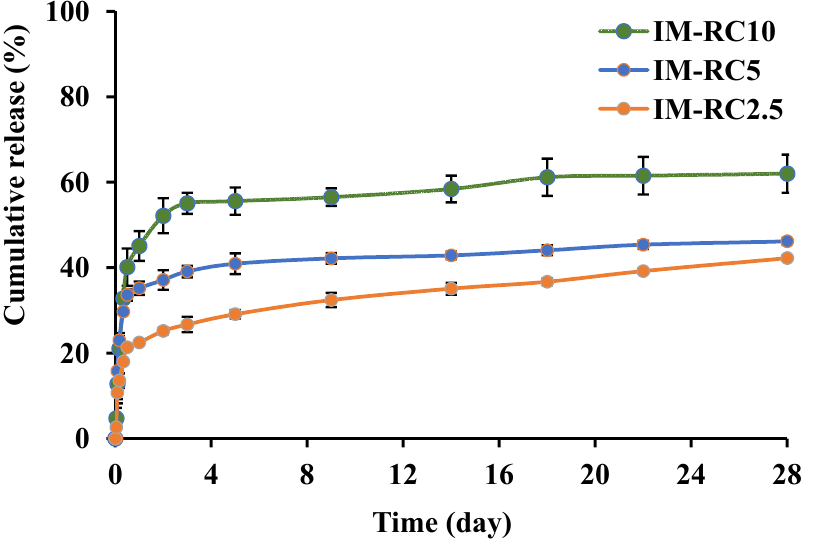
Figure 6. Effect of CO concentrations (2.5%, 5% and 10%) on the IM release from IM-loaded 55% w/w rosin/cinnamon oil-based ISG formulations ( n = 6).